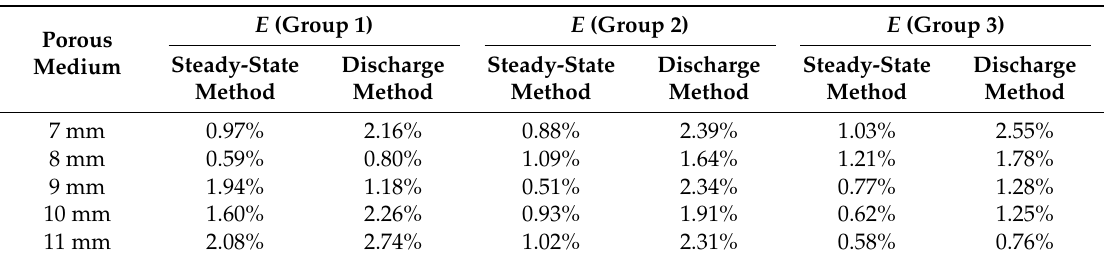
Table 5. Deviations from the experimental data by the steady-state method and the discharge